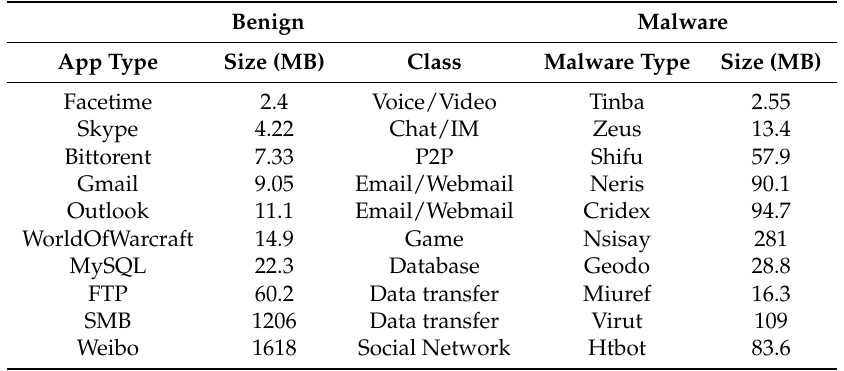
Table 2. Summary of benign and malware traffic in USTC-TFC2016 dataset. (Notations: SMB: Server Message Block; IM: Instant Message; P2P: Peer-to-Peer).